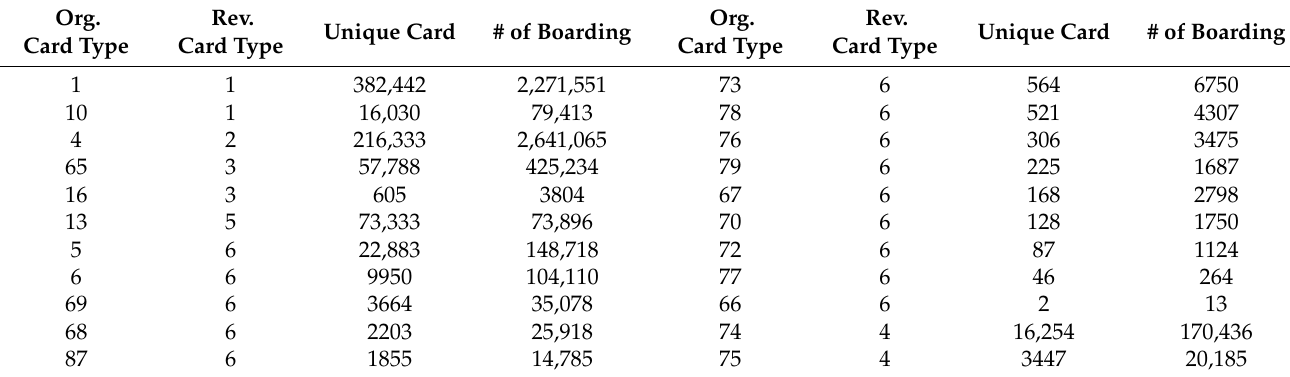
Table 2. Original and revised card types information based on users travel